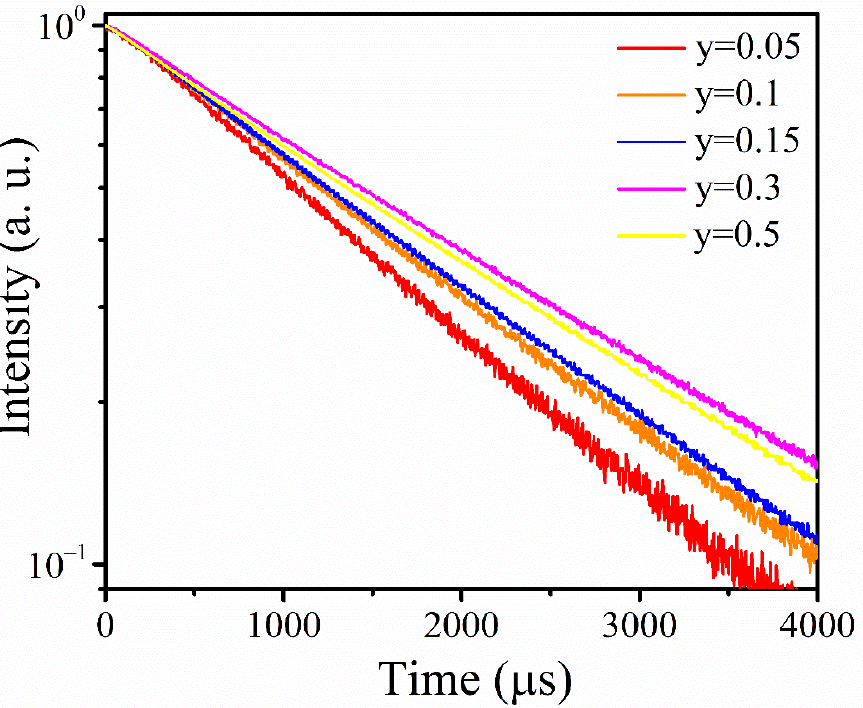
Figure 5. Fluorescence decay curves of Ho 3+ : 5 I 7 energy level monitored at 2050 nm in TGBTH-y glass samples.